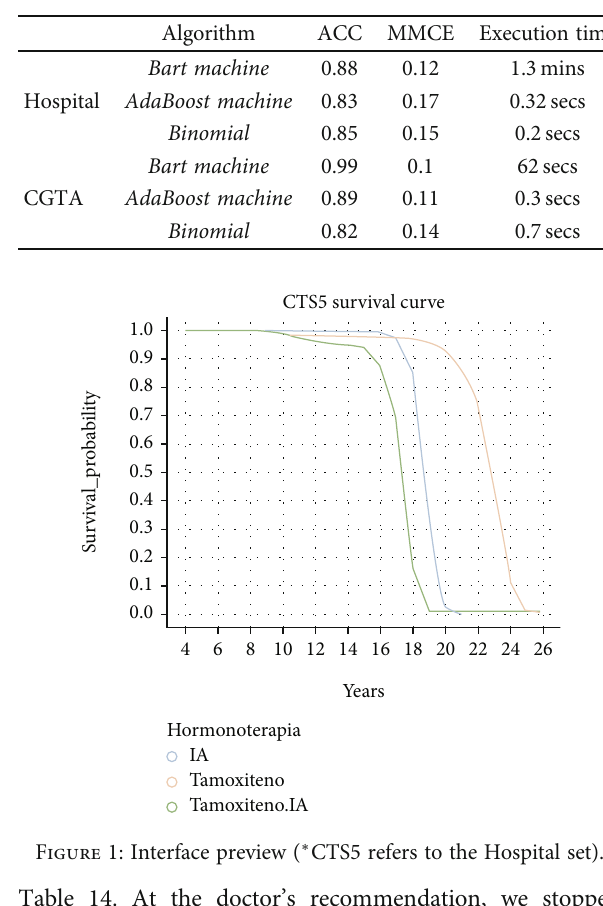
Table 16: Survival classi fi er results using mlr Hospital and TCGA. Table 17: Classifying results classi fi cation using mlr Hospital and TCGA.